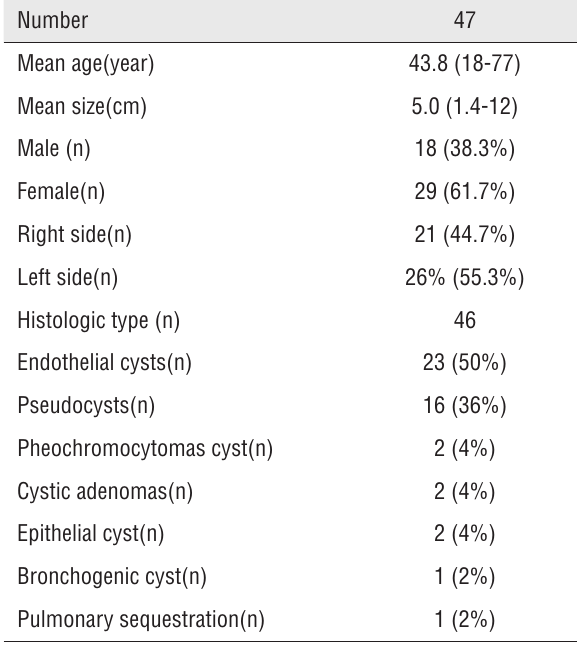
Table 1 - features of Patients with Adrenal cysts and pathological examination result.